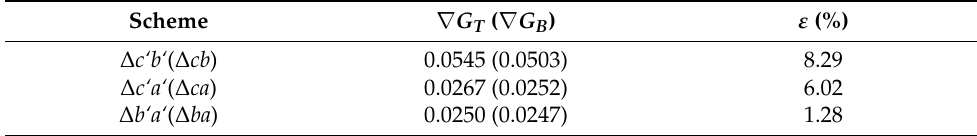
Table 7. Comparison between ∇ G in theory and